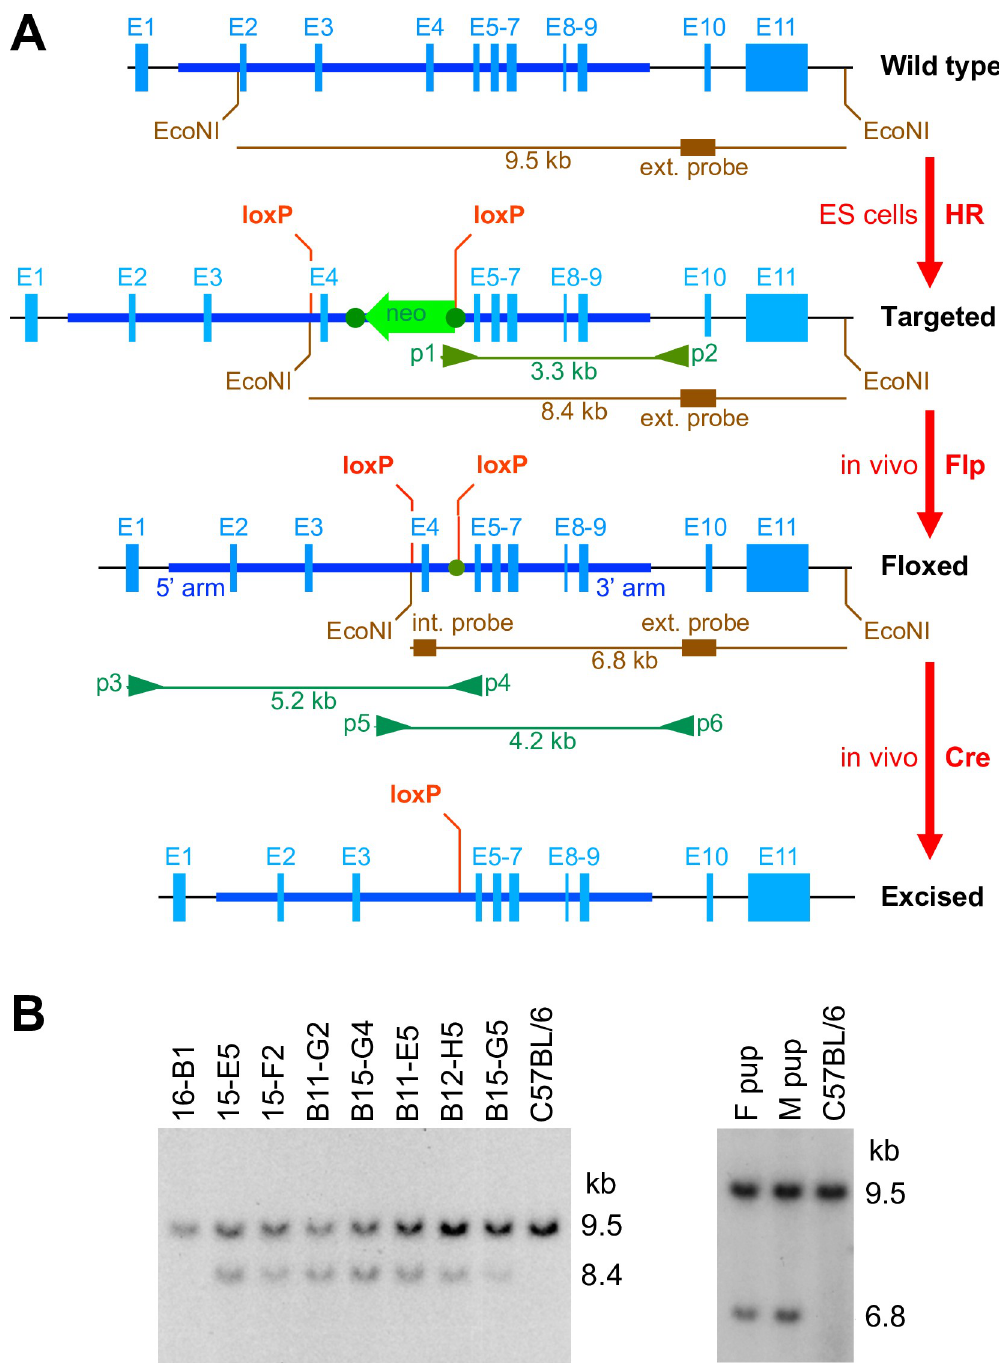
Fig 1. Poldip2 gene targeting strategy. A: Successive modifications of the mouse Poldip2 gene are shown from top to bottom. The wild type allele from the NCBI database (GRCm38.p6) includes 11 exons, represented by solid blue boxes E1-11. A classical homologous recombination (HR) strategy with a suitable targeting construct was used to flank exon 4 with loxP sites in embryonic stem (ES) cells. Following recombination, the targeted allele includes a neomycin cassette (neo) in antisense orientation in intron 4, surrounded by FRT sites (dark green dots), as well as loxP sites located in introns 3 and 4 (outside neo/FRT). Targeted ES cells were used to produce live chimeric mice. The floxed allele results from in vivo recombination of FRT sites and deletion of the neomycin cassette, after crossing with a Flp deleter transgenic line, thereby generating heterozygous floxed mice. Lastly, the excised allele, which is expected to inactivate Poldip2 , is produced by recombination of loxP sites and deletion of exon 4, after crossing with Cre transgenic mice. In these maps, the region